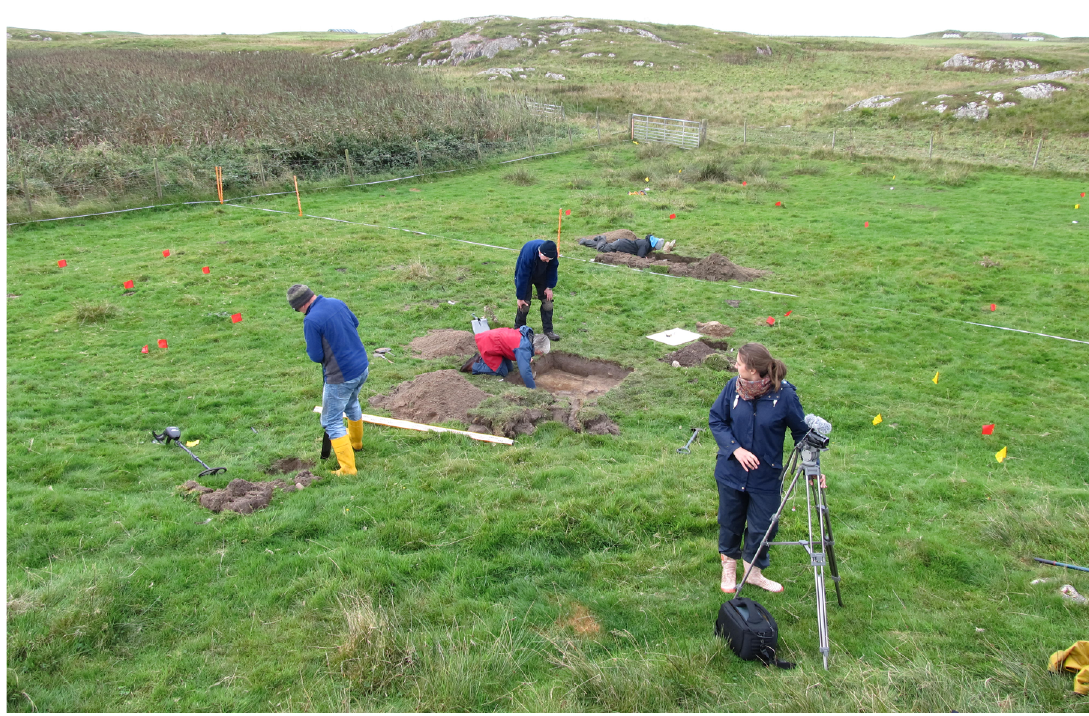
Fig. 2 TTU-led excavation of a complex Bronze Age metalwork deposition on the Isle of Coll, Argyll and Bute with valuable assistance from the